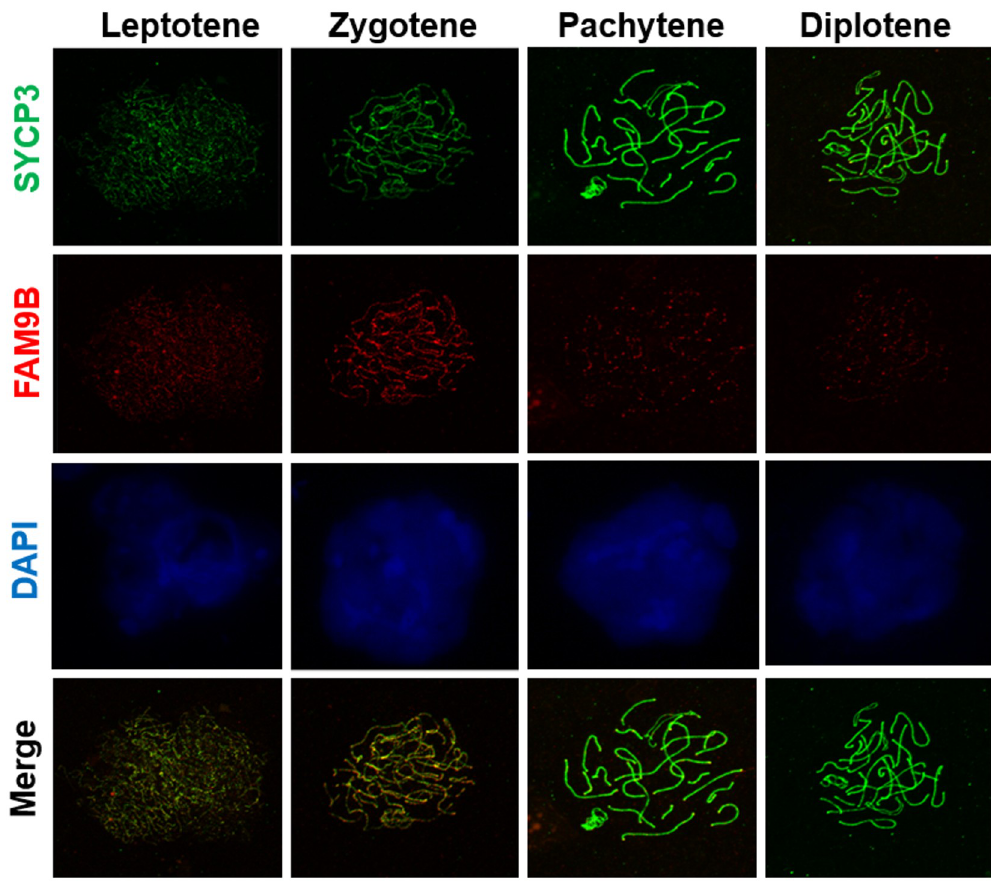
Fig 5. FAM9B and SYCP3 proteins are partly co-localized in chromosome sections. FAM9B is localized in the chromosome axis as distinct foci during (A) leptotene, (B) zygotene, (C) pachytene, and (D) early diplotene. SYCP3 were used to marker protein for all stages of meiotic prophase I. FAM9B (green) and SYCP3 (red) are co-localized in SC of chromosome sections in primary spermatocytes. The pictures are representative of three independent experiments. Scale bar = 5 μ